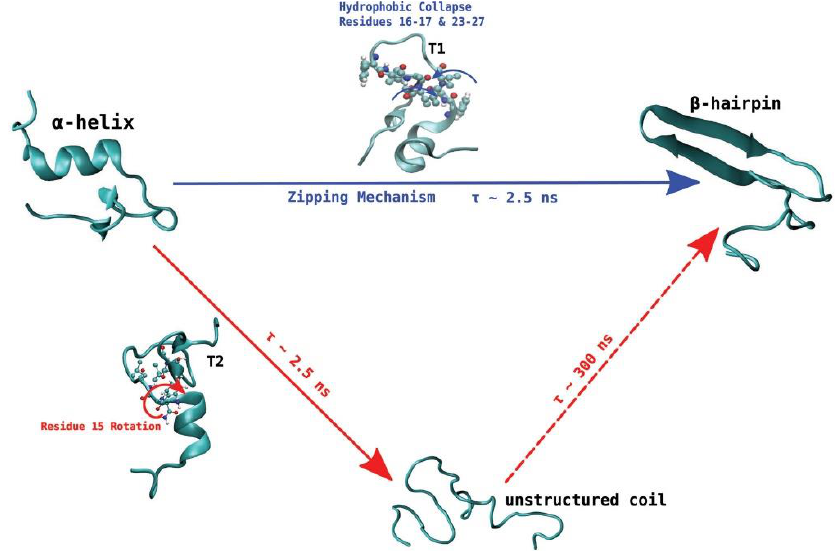
Figure 14. Proposed pathways of transition of hIAPP from an α-helical conformation to a β-hairpin. The zipping mechanism (in blue) involves the gradual loss in α-helical structure by the gain of β-hairpin characteristics. The second mechanism (in red) is a two-step transition process that involves the transformation of the α-helical state into an unstructured coil before eventually transitioning to β-hairpin. Adapted from Singh et al. [99] with the permission of AIP Publishing.